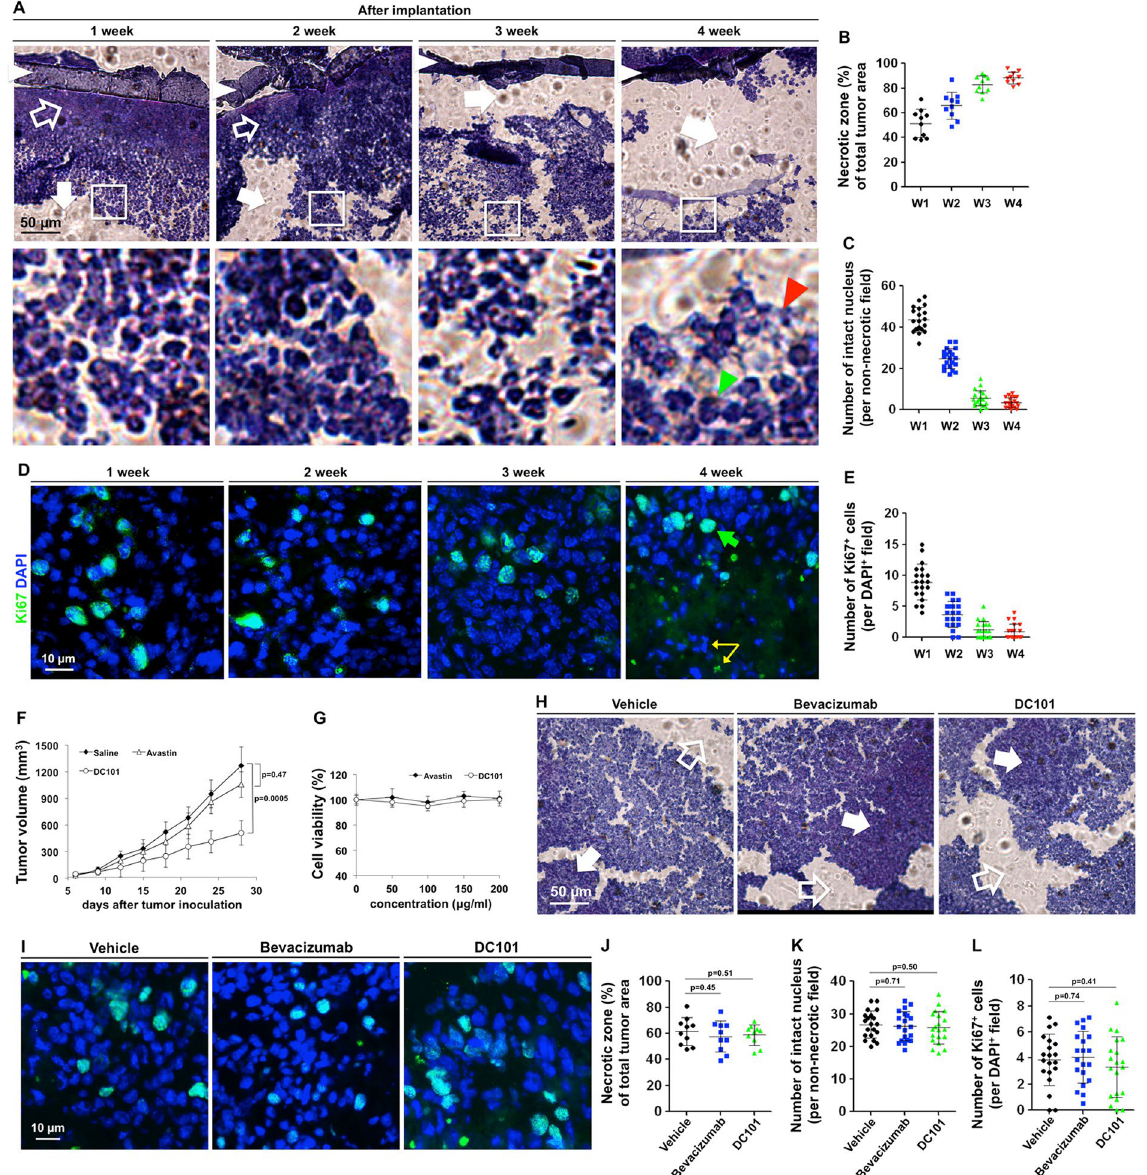
Figure 2. The tumor cells were not eliminated, even when their blood supply was entirely blocked. ( A ) The tumor samples were collected 1~4 weeks after implantation and stained with H&E. The open arrows indicate the coagulative necrosis, and the solid arrows indicate the liquefactive necrosis (shown as empty spaces, which were caused by the sectioning process). The white arrowheads indicate the membrane-barrier, the red arrowhead indicates the cell debris, and the green arrowhead indicates the cells with an intact nucleus. ( B ) The mean necrotic area of the samples was quantified using 10 slides (2 slides from each sample) per group. ( C ) The number of intact nuclei per non-necrotic field was counted using 20 randomly chosen fields (4 fields from each sample) per group. ( D ) The tumor samples were stained with Ki67 and DAPI. Note that the yellow arrows indicate the un-overlapped green/blue fluorescence, which were not considered active cells but only cell debris. ( E ) The number of Ki67 + cells (with an intact nucleus) per DAPI + field was quantified in 20 randomly chosen fields. ( F ) Bevacizumab (10 mg/kg), DC101 (40 mg/kg), or vehicle (saline) was directly injected into the tumors with blood supply (the orthotopic tumor) or without blood supply (the encapsulated tumor). The tumor volume was measured every 3 days. ( G ) 4T1 cell viability was measured after the treatment of bevacizumab and DC101. ( H – L ) The encapsulated tumors were collected 2 weeks after drug injection and stained with H&E ( H ), or Ki67 ( I ). The mean necrotic area ( J ), the number of intact nuclei per non-necrotic field ( K ), and Ki67 + cells ( L ) of the samples was quantified as described above. The data are presented as scatter plots with means ±